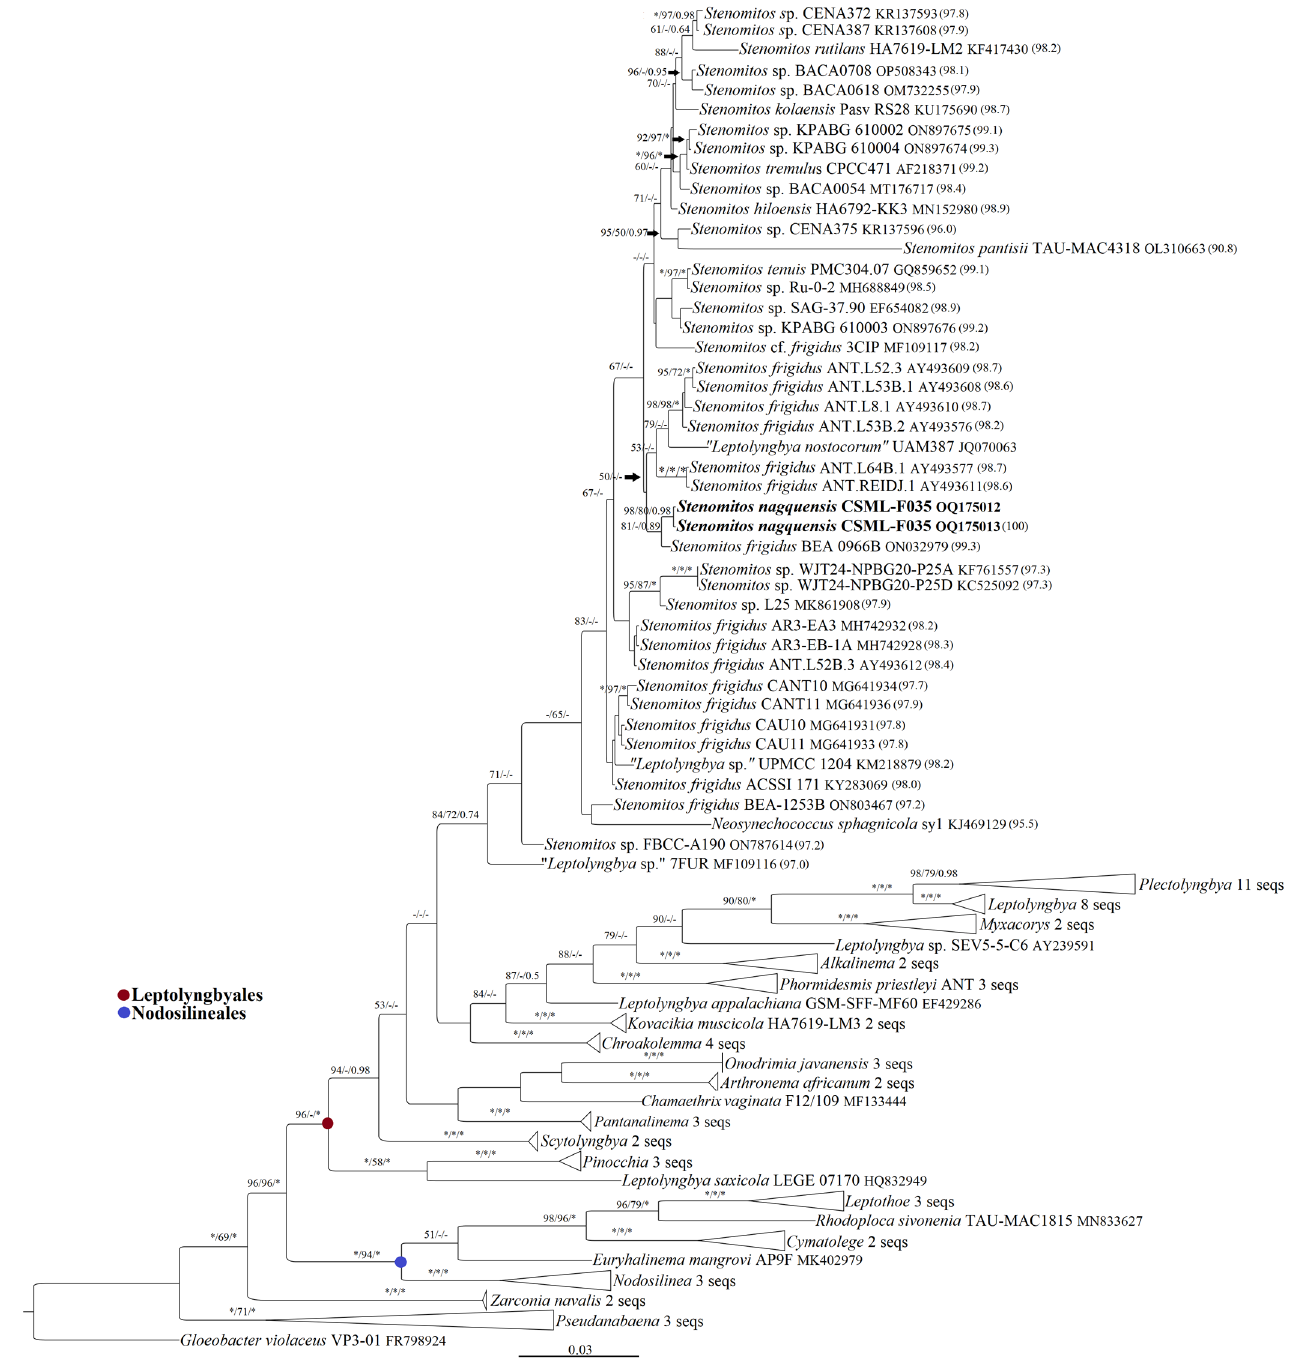
Figure 4. Maximum-likelihood (ML) phylogenetic tree based on the 16S rRNA gene, with node supports from ML, neighbor-joining, and Bayesian inference. Bootstrap and posterior probability values from 99 to 100/1.0 are represented by asterisks (*). The novel species Stenomitos nagquensis , written in bold, is separated on a unique node with high support values. Accession numbers are provided after each taxon name, and the numbers in parentheses after the accession numbers are the percentage similarity values between Stenomitos nagquensis and the taxon.